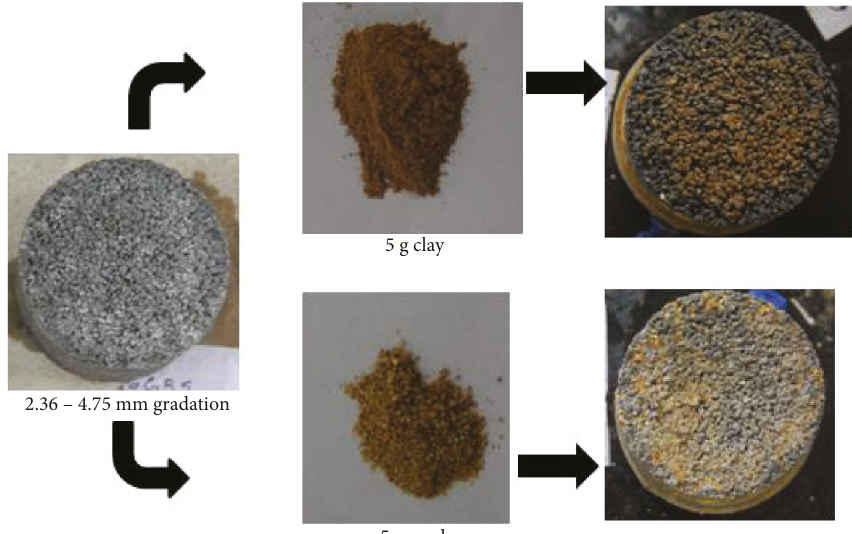
Figure 3: Clogging of clay and sand on the pervious concrete mix—2.36–4.75mm narrow gradation.